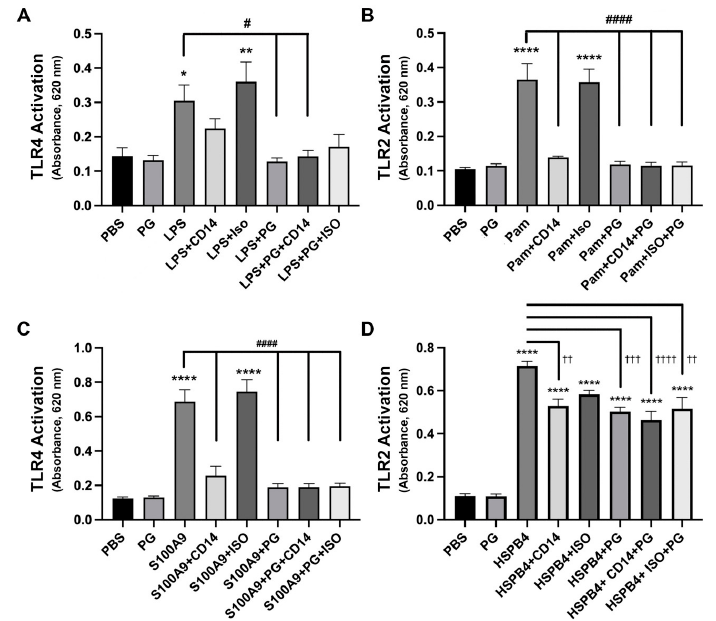
Figure 7. TLR4 activation by LPS and S100A9, and TLR2 activation by Pam and HSPB4, were inhib- ited by DOPG. This inhibition was not affected by the presence of a CD14-blocking antibody. The activity of secreted alkaline phosphatase as an indicator of TLR activity was measured as absorbance at 620 nm. Experiments were performed on three separate occasions, with results representing the means ± standard error of the mean. ( A ) HEK-Blue-hTLR4 reporter cells were incubated with 0.001 µ g/mL LPS in the presence or absence of 100 µ g/mL DOPG and/or 2.5 µ g/mL anti-CD14 or Iso- type control antibody (ISO). ( B ) HEK-Blue-hTLR2 reporter cells were incubated with 0.00003 µ g/mL Pam in the presence or absence of 10 µ g/mL DOPG and/or 5 µ g/mL anti-CD14 or ISO. ( C ) HEK- Blue-hTLR4 cells were incubated with 3 µ g/mL recombinant S100A9 in the presence or absence of 100 µ g/mL DOPG and/or 2.5 µ g/mL anti-CD14 antibody (CD14) or ISO. ( D ) HEK-Blue-hTLR2 reporter cells were incubated with 1 µ g/mL HSPB4 in the presence or absence of 1 µ g/mL DOPG and/or 1 µ g/mL anti-CD14 or ISO. * p < 0.05, ** p < 0.01, **** p < 0.0005 versus the PBS